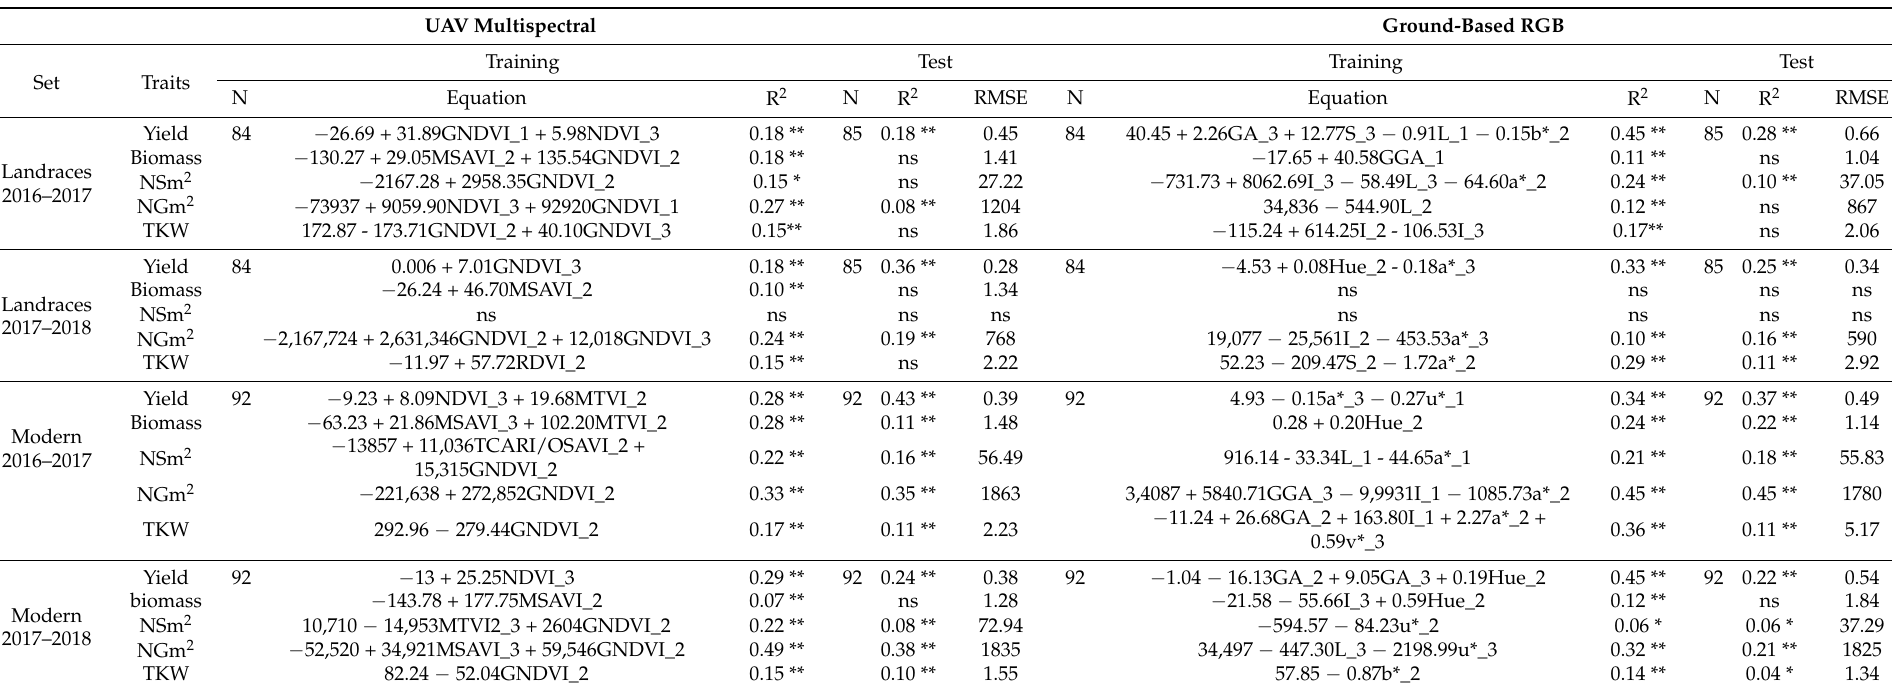
Table 7. Training and test statistics of the models for the estimations of agronomic traits through UAV multispectral and RGB VIs for each germplasm set and growing season. * p < 0.05. ** p < 0.01. N, number of genotypes; R 2 , determination coefficient; RMSE, root mean standard error; Yield (t/ha); NSm 2 , number of spikes per square meter; NGm 2 , number of grains per square meter; TKW, thousand kernel weight (g); I, intensity; L, lightness; S, saturation. Number after each VI means the flight occasion: 1, 128 DAS; 2, 151-153 DAS; 3, 179-184 DAS. UAV Multispectral Ground-Based